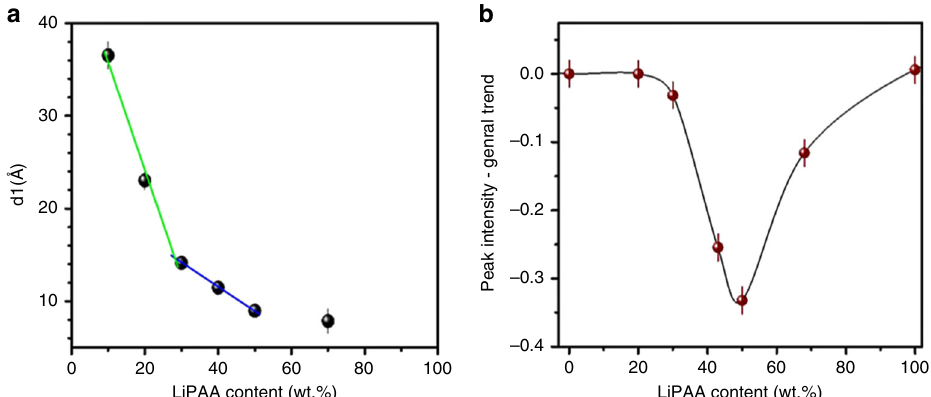
Fig. 4 Structural evolution of the electrolytes. a SAXS: Evolution of the correlation distances d 1 as a function of the LiPAA content in the electrolytes. b WANS : Deviation to the trend of the peak intensity for q 2 (at 1.27 Å − 1 , d 2 = 5 Å), displayed as a function of the LiPAA content in D 2